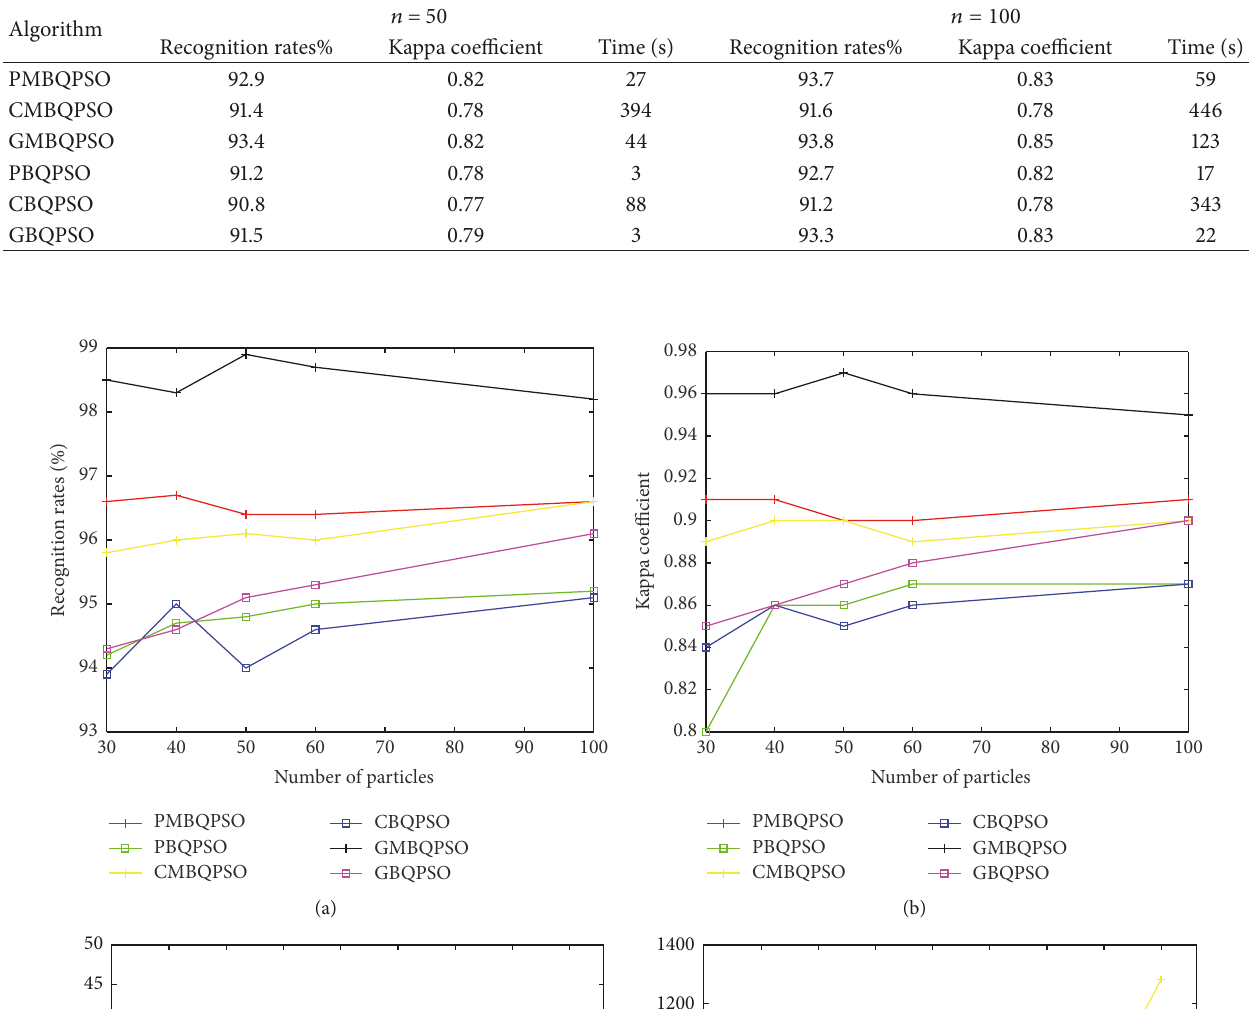
Table 5: Results of subpixel mapping with spatial resolution enhancement ratio 5 × 5 .